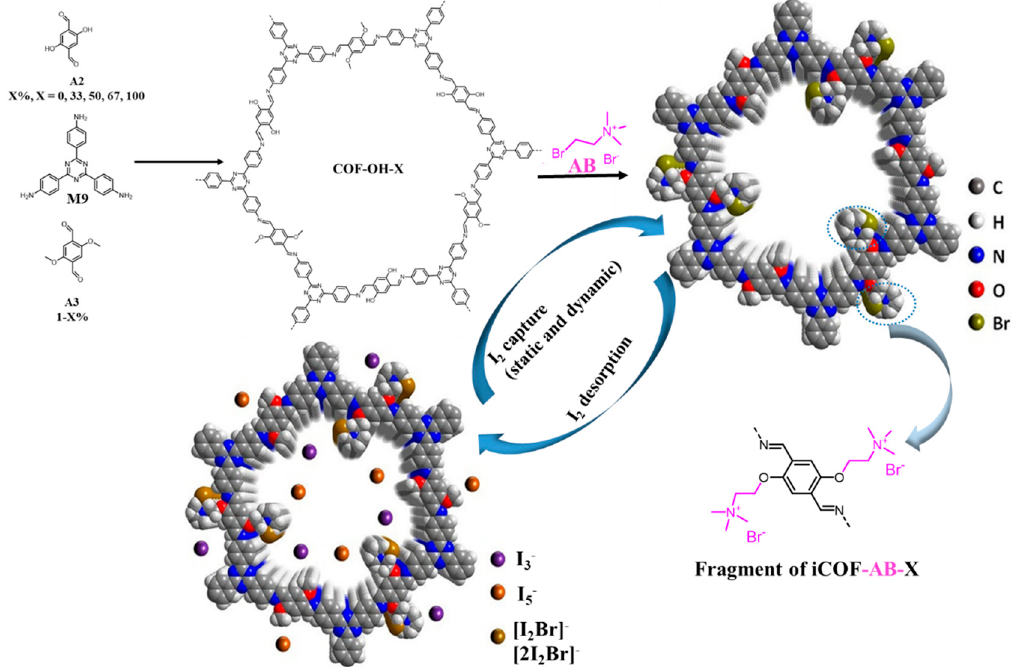
Figure 13. Synthetic procedure of multivariate COF-OH-X and iCOF-AB-X materials. Schematic illustration of iCOF-AB-X for I 2 capture. Reprinted/adapted with permission from Ref. [51]. Copyright (2022), John Wiley and Sons.